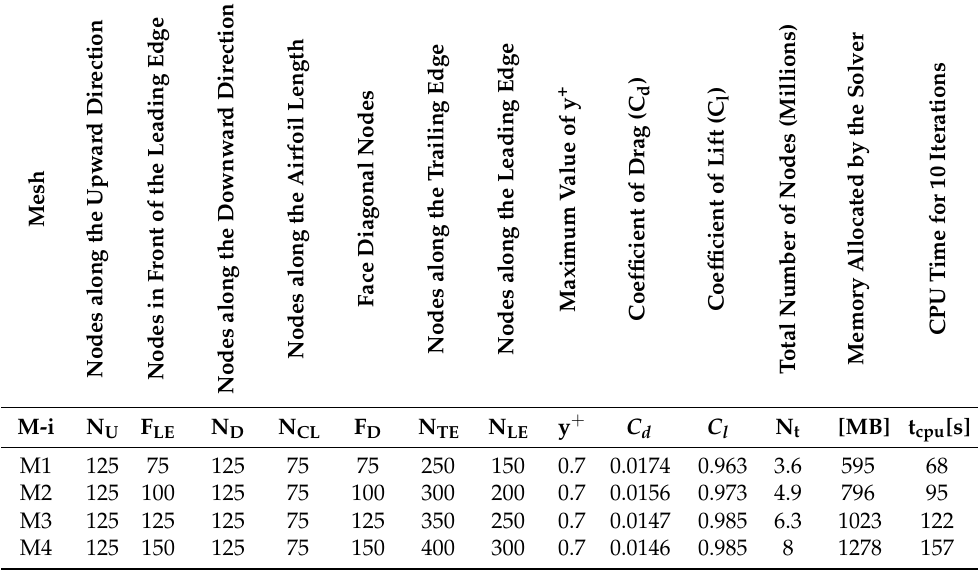
Table 4. Distribution of mesh in the computational domain for the mesh independence